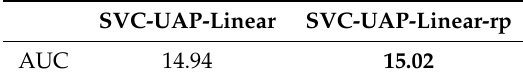
Figure 5. Evolution of the AUC of the AR-AN curve when varying the threshold r of the rank-pooling filter. The model is configured to use a linear kernel for the SVC module. Table 3. Comparison between SVC-UAP-linear (without rank-pooling) and SVC-UAP-linear-rp (with